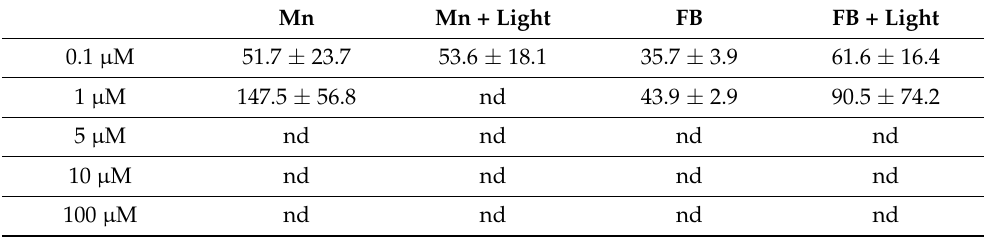
nd, not detectable value in the tested